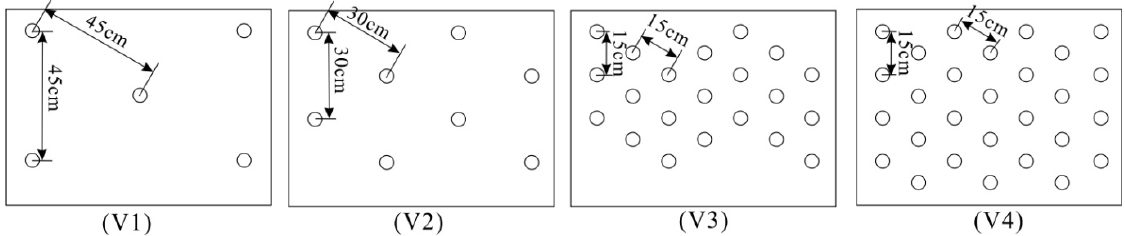
Figure 3. Vegetation distribution